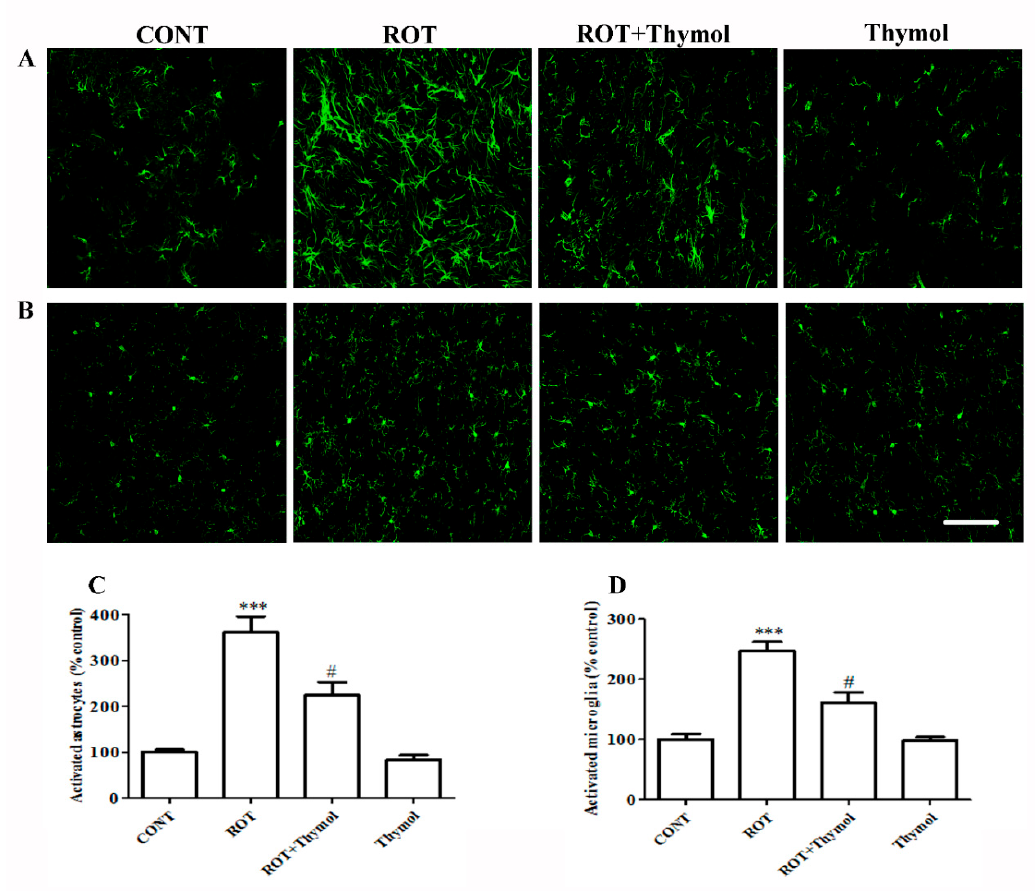
Figure 4. The immunofluorescence staining of GFAP ( A ) and Iba1 ( B ) in the striatum region of different experimental groups. Intense immunoreactivity of GFAP positive astrocytes ( A ) and Iba-1 positive microglia ( B ) were observed in the ROT challenged rats as compared to CONT rats. Thymol treatment to ROT challenged rats exhibited modest staining of GFAP and Iba-1 when compared to rats injected ROT (Scale bar 200 µ m). Quantification data showed significant (*** p < 0.001) increased percentage number of activated astrocytes ( C ) and microglia ( D ) in ROT injected animals when compared to CONT rats. However, thymol treatment to ROT injected rats showed significantly (# p < 0.05) reduced percentage number of activated astrocytes and microglia as compared to rats injected with ROT alone. The values are presented as percent mean ± SEM ( n = 3).